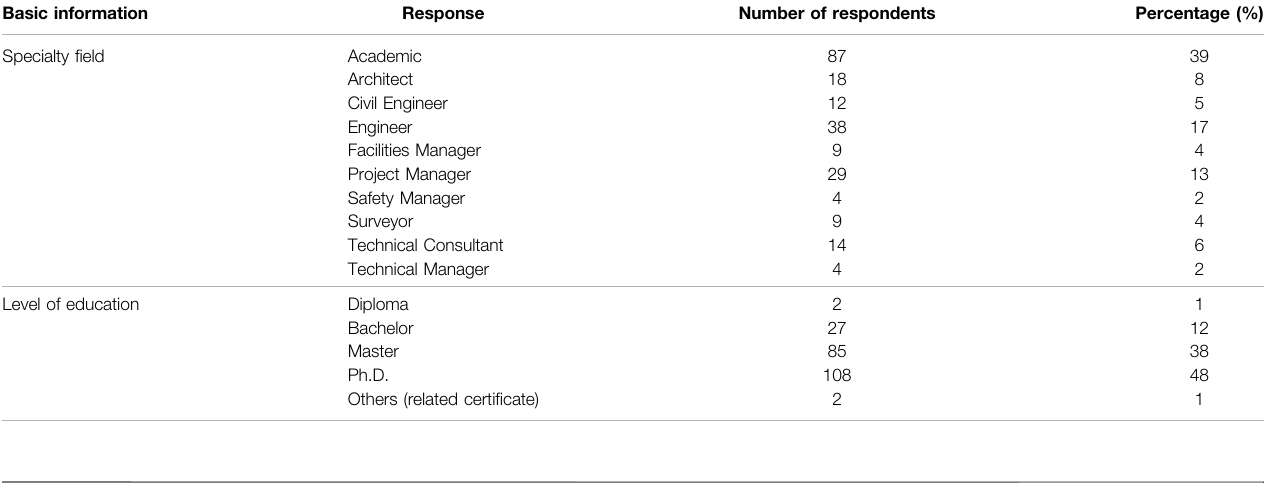
TABLE 2 | Details of the survey participants.